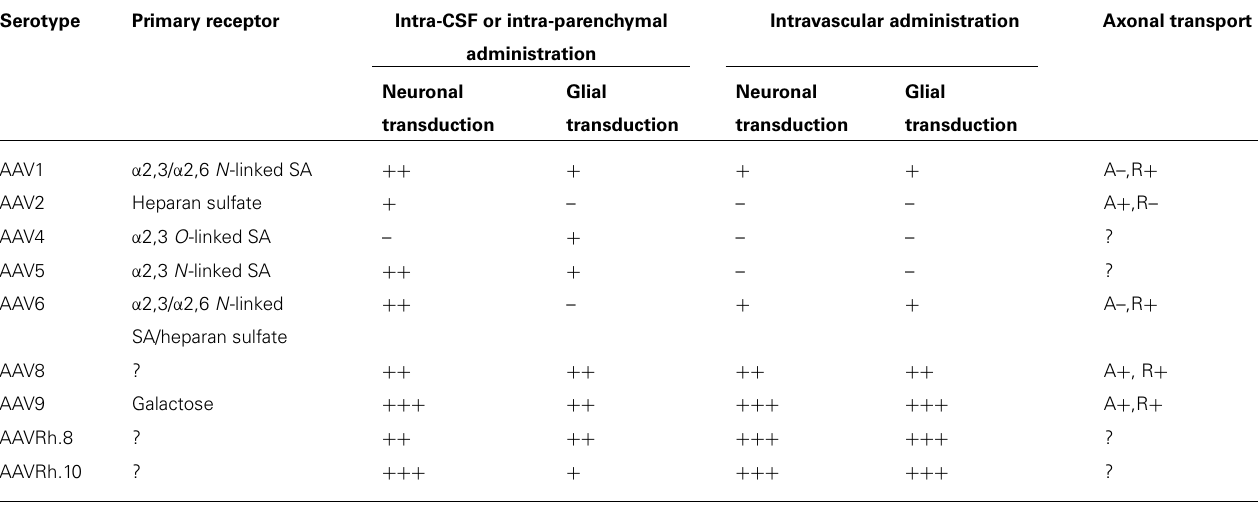
Table 1 | Capsid-receptor interactions, transduction profiles, and axonal transport properties of some of the well-characterized adeno-associated viral serotypes in the mammalian CNS.